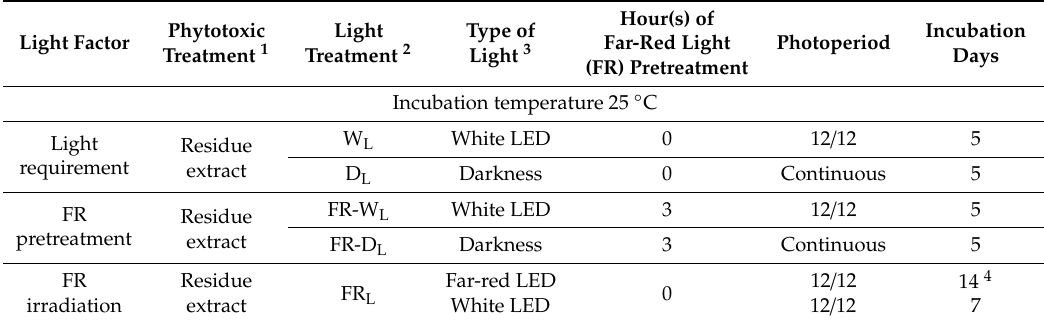
Table 1. The experimental conditions of the laboratory